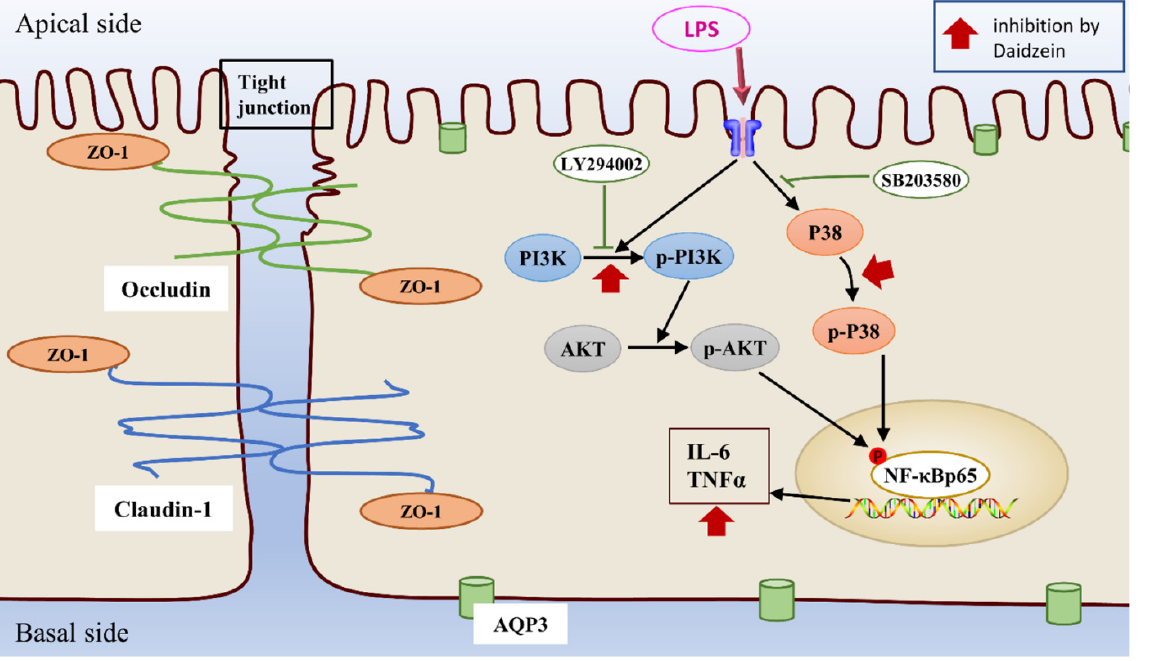
Figure 8. The possible mechanism of daidzein in the treatment of LPS-induced intestinal epithelial barrier injury.